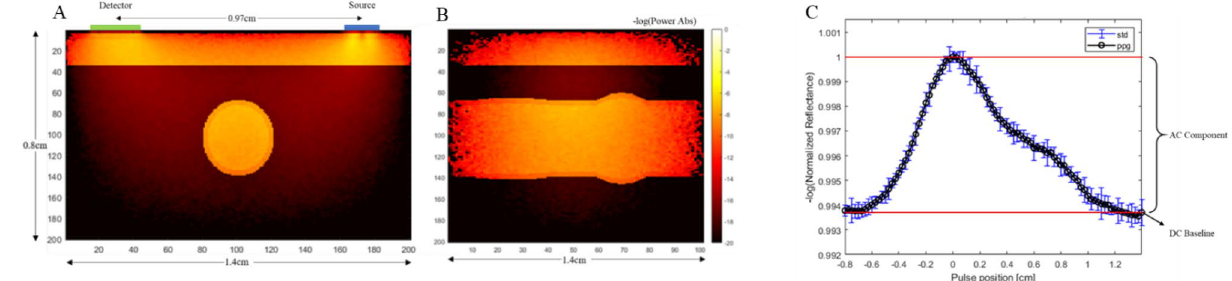
Figure 4. Monte Carlo slices of the negative logarithm of power absorbed color map of radial artery configuration at single pulse location at 660 nm wavelength. ( A ) and ( B ) shows the front view and side view, respectively. ( C ) PPG Curve generated for non-obese case. PPG signal is developed through normalized reflectance signal collected at each pulse position.